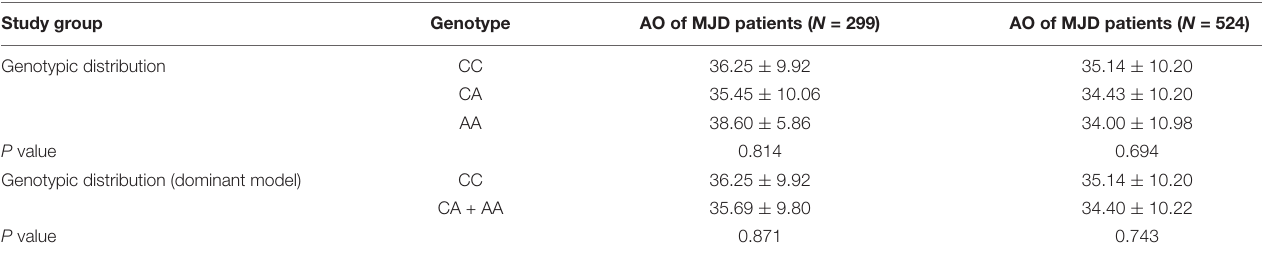
TABLE 4 | AO differences among different genotypes of rs11100494 in the NPY5R gene after adjusting for the effect of expanded CAG